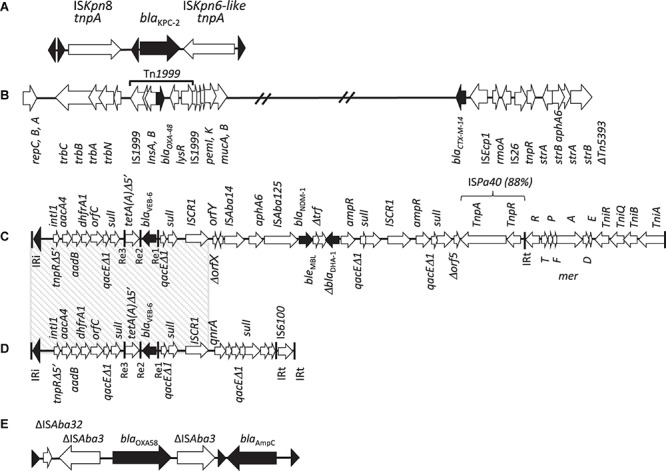
Genetic environments of β-lactamase genes identified in P. mirabilis. (A) Fragment 3,241 pb from P. mirabilis, China, 2015 (Hu et al., 2012), containing blaKPC–2, ISKpn8 and ISKpn6-like, chimera of several elements of transposons Tn4401 and Tn3, as described for K. pneumoniae KP048 (Shen et al., 2009); (B) plasmid fragment from OXA-48 and CTX-M-14 -producing P. mirabilis, Gaza, Palestine (Chen et al., 2015); (C) PGI1-PmPEL genomic island, France, 2016 (Girlich et al., 2015), with the multidrug resistance region (MDR) containing the blaNDM–1 and blaVEB–6
(D) genes and comparison with SGI1-V from P. mirabilis, France, 2009 (Siebor and Neuwirth, 2011), containing a 17,1 kb MDR on a complex class 1 integron, including blaVEB–6, aacA4, aadB and dhfrA1 genes bracketed by two 3′ conserved segments (3′-CS); (E) chromosomal fragment from P. mirabilis 1091 isolate, Belgium, 2017 (Girlich et al., 2017), containing blaOXA–58 [from A. baumannii (Bonnin et al., 2013b)] and blaAmpC (from an uncultured bacterium, GenBank N°AMP47568) genes, related to Acinetobacter bohemicus (GenBank N° WP_004650432). Triangles represent tandem repeats of 14-pb. The β-lactamase genes and their orientation are represented by black arrows and ISs by black triangles.